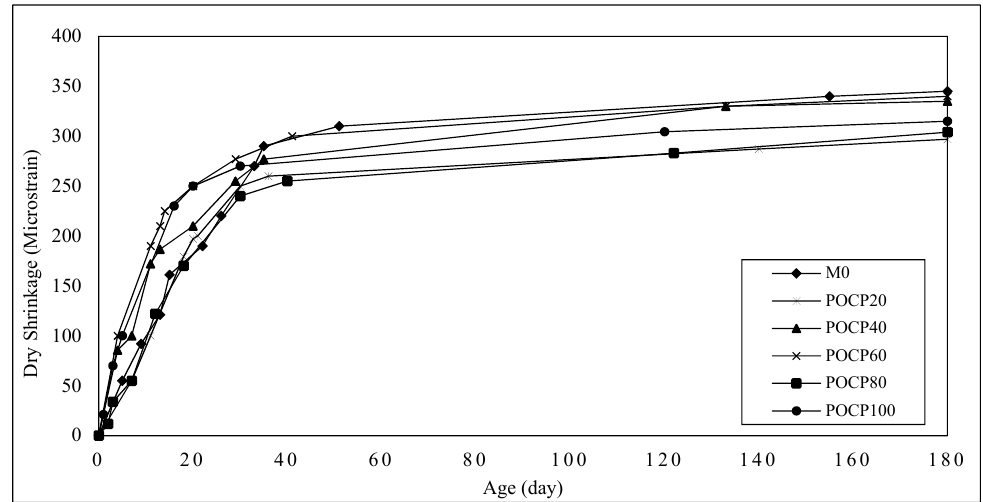
Figure 27. Water absorption of POCP concrete at different ages.